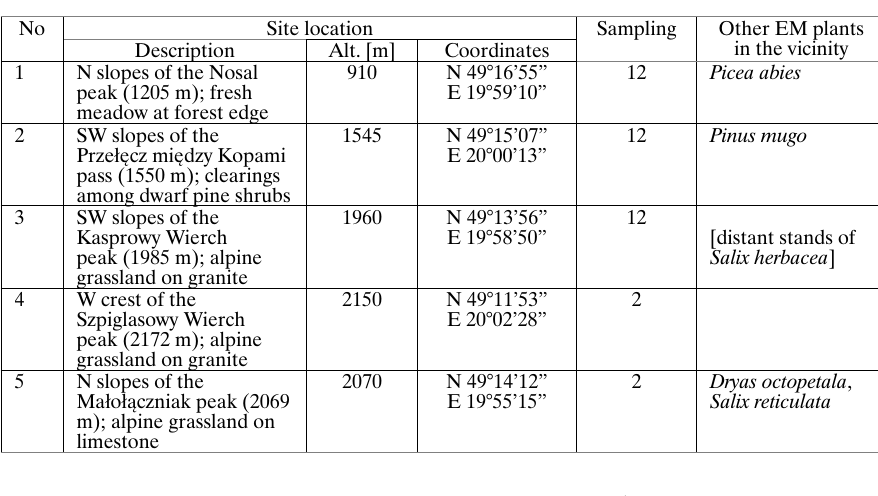
Description of sampling sites (all within the Western Carpathians, the Tatra Mts.). In the “sampling” column: 1 sampling in May 1997; 2 sampling in September